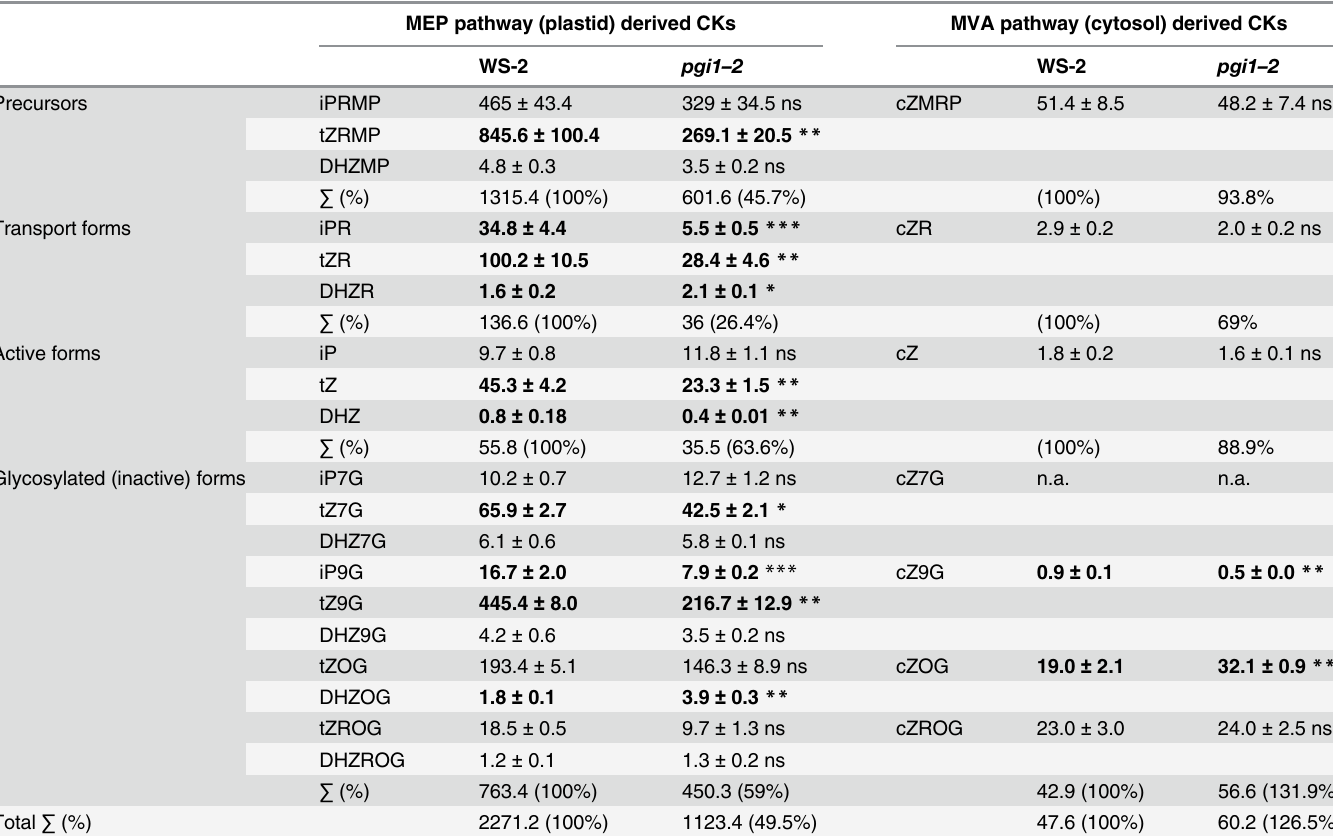
Table 2. CKs content (pmol g -1 DW) in leaves of 30 DAG Ws-2 and pgi1 – 2 plants. CK precursors, transport forms, active forms and glycosylated inactive forms are separated in two groups based on their origin from MEP and MVA pathway, respectively. Total sums and corresponding percentage is shown for in- dividual forms. Symbols indicate significant differences according to ANOVA. * < 0.05; ** < 0.01; ** < 0.001; ns, not significant; n.a., not